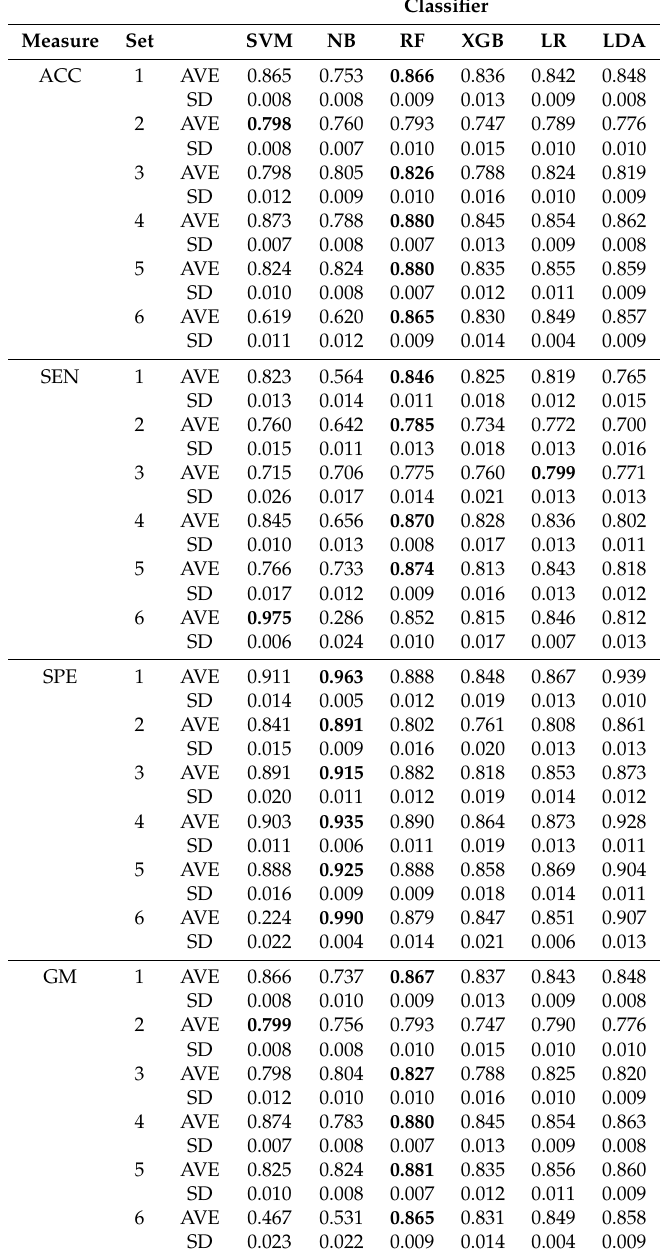
Table 2. The AVEs and SDs of the ACC, SEN, SPE and GM values of the SVM, NB, RF, XGB, LR, and LDA classifiers with 6 collections of features for the 5-fold CV results based on 100 rounds, where the highest AVEs of the ACC, SEN, SPE, and GM values among the 6 classifiers for each set of features are marked in